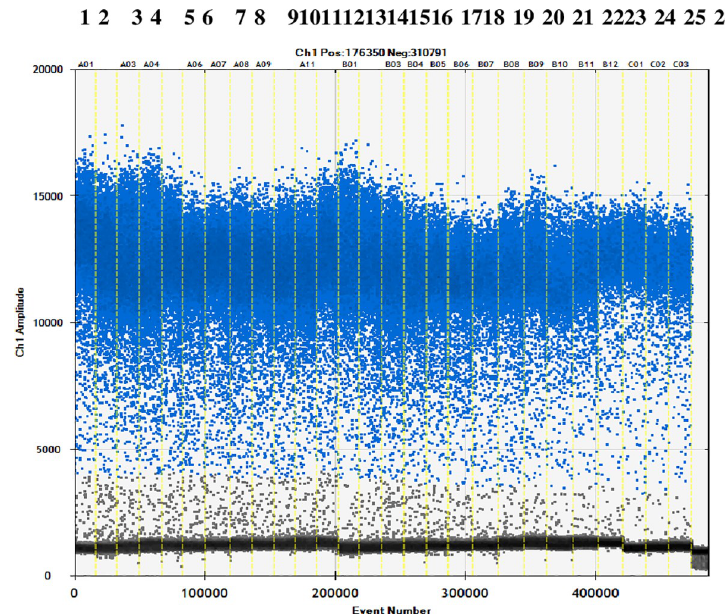
Fig 5. Copy number of cassava and sweet potato ratio. Channels 1–3: starch mixture containing 90% cassava starch; channels 4–6: starch mixture containing 80% cassava starch; channels 7–9: starch mixture containing 70% cassava starch; channels 10–12: starch mixture containing 60% cassava starch; channels 13–15: starch mixture containing 50% cassava starch; channels 16–18: starch mixture containing 40% cassava starch; channels 19–21: starch mixture containing 30% cassava starch; channels 22–24: starch mixture containing 20% cassava starch; channels 25–27: starch mixture containing 10% cassava starch; and channel 28: sterile double-distilled water. https://doi.org/10.1371/journal.pone.0228624.g005 3.2.2. Detection of the relationship between the copy number of ddPCR and the concen- tration of cassava DNA. The extracted DNA was diluted to a gradient of 1, 5, 10, 15, 20, and 25 ng/ μ L; there were three replicates for each concentration, and 4 μ L of DNA was used for ddPCR. The results are shown in Table 4. The copy number of cassava increased with increased DNA content. There was a significant linear relationship. The coefficient of variation was 8.85%, and this was far below the coefficient of variation required by the regulations. The average copy number and DNA content of the three replicates were linearly fitted (Figs 3 and 4) with a correlation coefficient R 2 of 0.992.